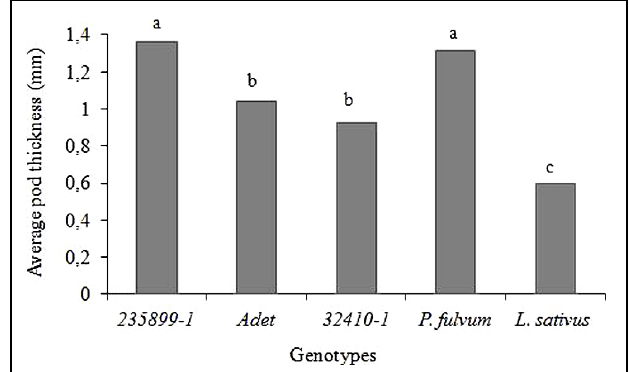
FIGURE 4 | Pod wall thickness of P. sativum , P . fulvum and L. sativus genotypes. Bars marked with different letters are significantly different (Tukey’s test: P <